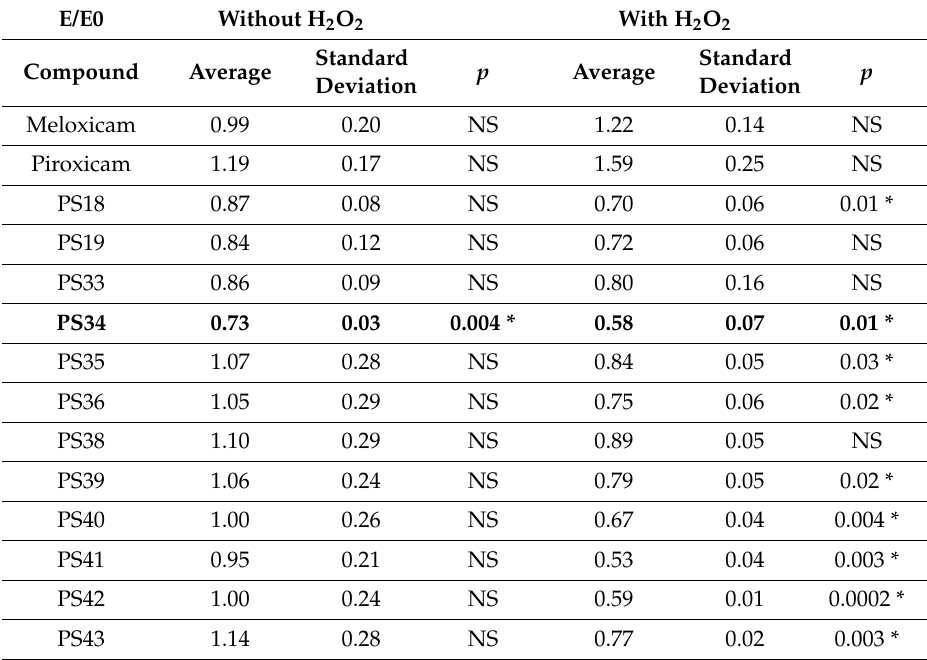
Table 2. Comparison of the free radical activity of the compounds studied (100 µ M) using DCFH-DA (2 (cid:48) ,7 (cid:48) -dichlorodihydrofluorescein diacetate) (mean (SD); n = 3). E/E0 Without H 2 O 2 With H 2 O 2 Standard Standard p p Average Compound Average Deviation Deviation Meloxicam 0.99 0.20